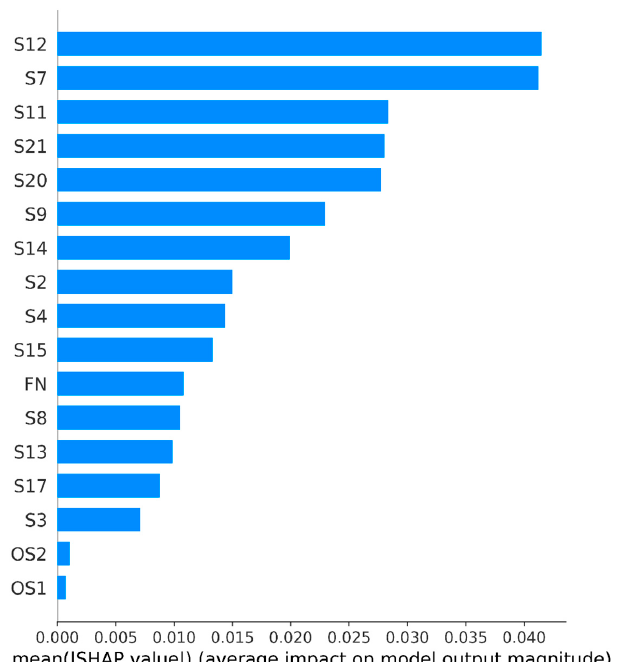
Figure 8. Histogram of the contribution of the features, where the contribution of each feature is taken as the average absolute value of this feature for all engines. taken as the average absolute value of this feature for all engines.